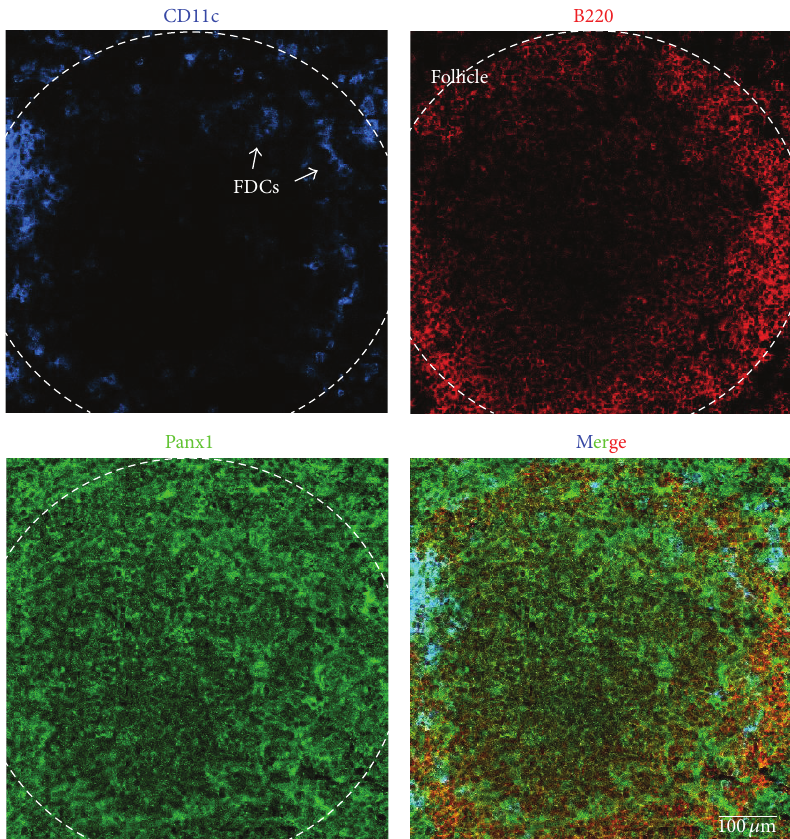
Figure 3: Dendritic and B cells of mouse spleen present pannexin1. Immunofluorescence of adult mice spleen cryosections (8 𝜇 m thick) fixed in ethanol (70% v/v) at − 20 ∘ C for 20min, mounted in Fluoromount-G and observed in a confocal microscope (Olympus, FluoView FV1000). Pannexin1 (Panx1 in green: primary antibody: rabbit anti-Panx1 antibody and secondary antibody goat anti-rabbit IgG conjugated to FITC) immunoreactivity is shown. Cells were identified by their reactivity to specific antigens as follows: dendritic cells (DCs) by CD11c (blue, monoclonal mouse antibody conjugated to allophycocyanin) and B cells by B220 (red, monoclonal mouse antibody conjugated to phycoerythrin) in a follicle. Arrows denote follicular DCs (arrows). Merge is also shown. Scale bar: 100 𝜇